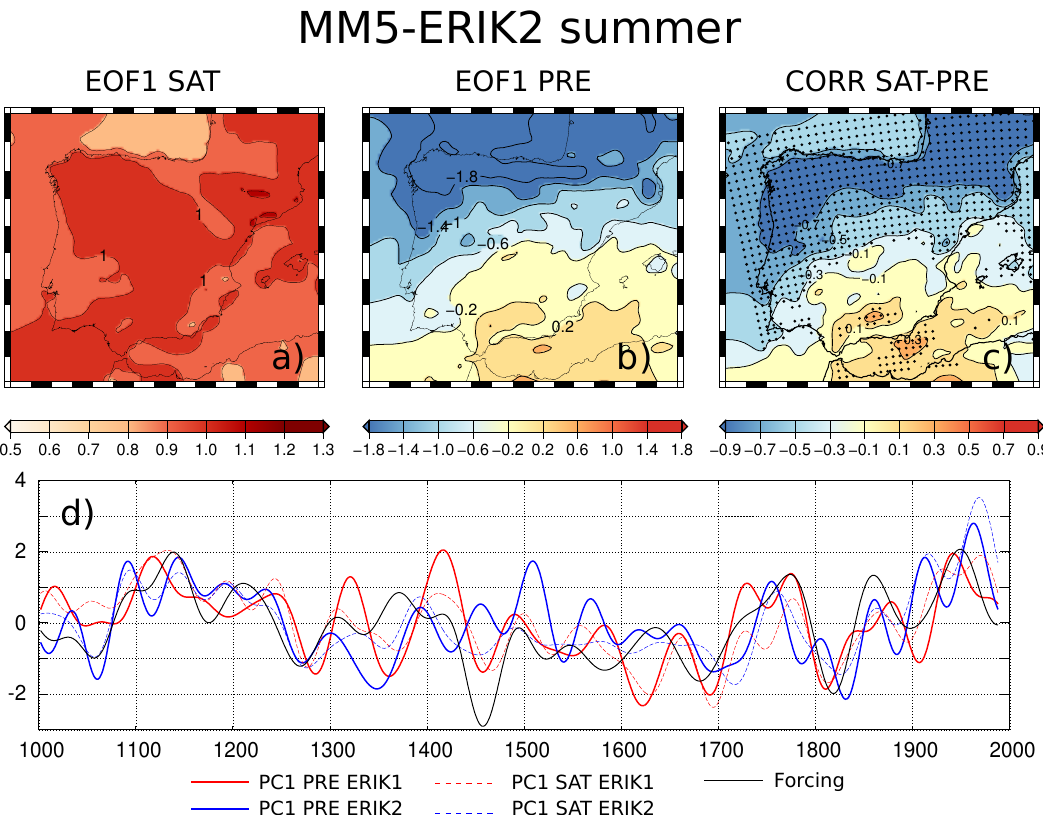
Fig. 5. Evolution of the summer (June–August) SAT and PRE during the last millennium in the two simulations. The three top maps show the first EOF of the standardised SAT (a) and PRE (b) , as well as the correlation between these two variables (c) . All maps are dimensionless, and correspond to the MM5-ERIK2 experiment, since the corresponding maps for MM5-ERIK1 are very similar (not shown). (d) shows the normalised PCs associated with the two variables in the two experiments, as well as the external radiative forcing. All calculations were performed with the smoothed low-frequency series. Black circles denote grid points where the correlation is significant at the 95% confidence level according to a bootstrap method (Ebisuzaki,